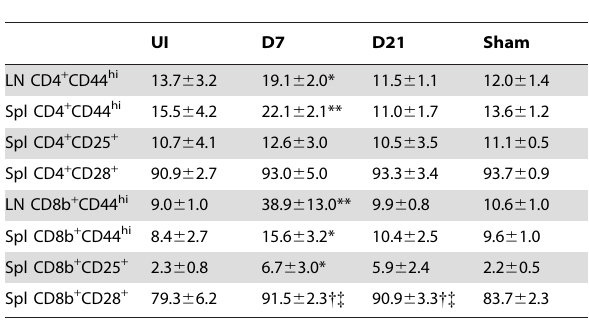
decreased in Rag-1 + CD8 compared with Rag-1 2 / 2 mice (Table 2). Rag-1 2 / 2 mice that received CD4 + T cells (Rag- 1 + CD4; Figure 4F and G) had similar neointima area and intima:media ratio (Table 2) compared with Rag-1 2 / 2 mice without T cell transfer. There were no significant differences in vessel size as determined by external elastic lamina area (Table 2).